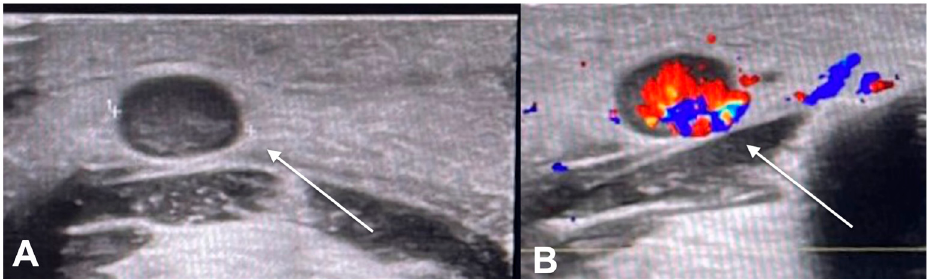
Figure 3. US examination. Submandibular metastatic lymph node of squamous cell carcinoma. ( A ) The lymph node appears round in shape, without hilum differentiation. ( B ) Colorimetric enhancement on Color Doppler examination.